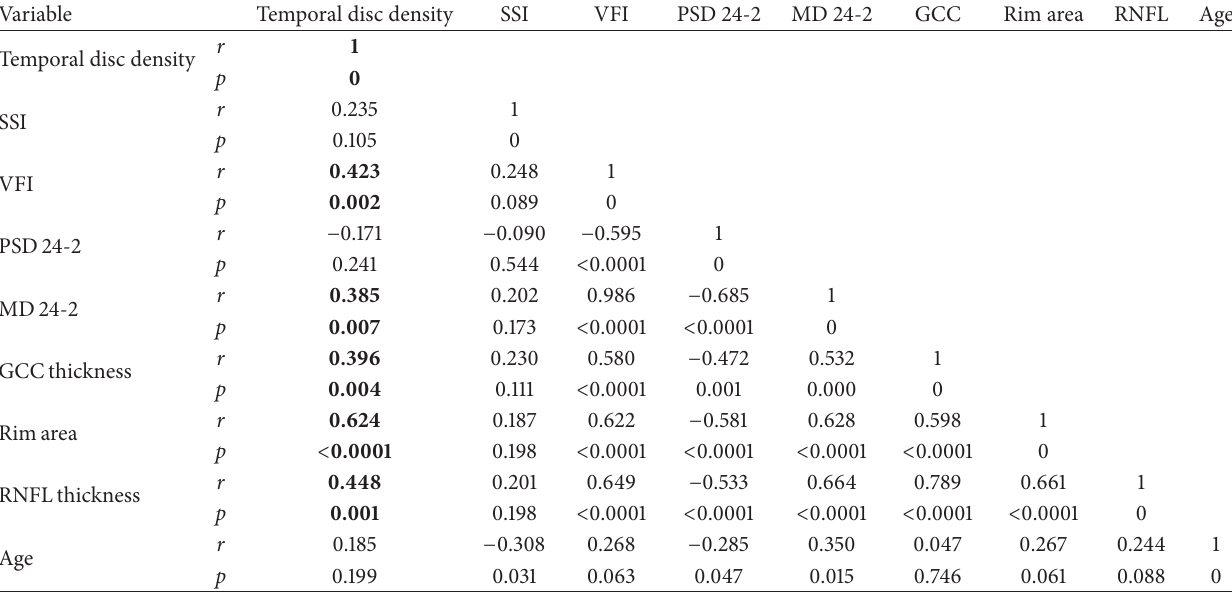
Table6:Pearsoncorrelationcoefficientmatrixforvisualfield,structuralvariables,andtemporaldiscvesseldensityinsubjectswithglaucoma.